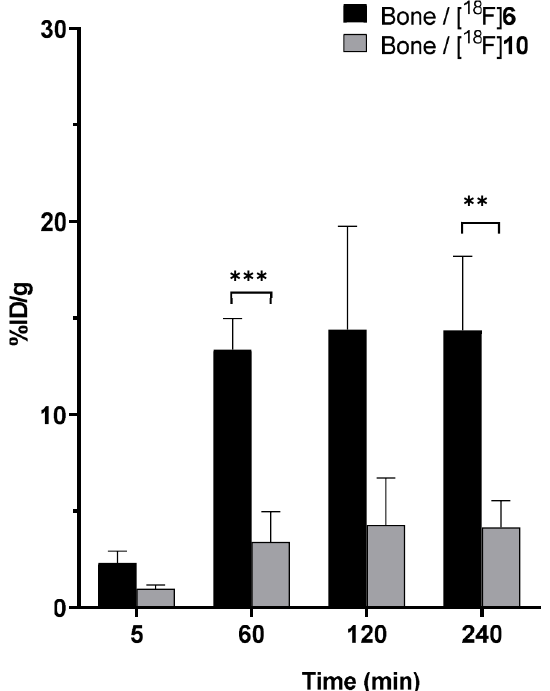
Figure 7. Comparison of the radioactivity accumulated in bone (tibia) in the biodistribution studies of [ 18 F]SiFA-Tz ([ 18 F] 6 ) and [ 18 F]fluoroalbumin ([ 18 F] 10 ). A significant enhancement in stability was seen for the albumin-bound [ 18 F]SiFA group in [ 18 F] 10 ( ** p ≤ 0.01, *** p ≤ 0.001), compared to [ 18 F] 6 .